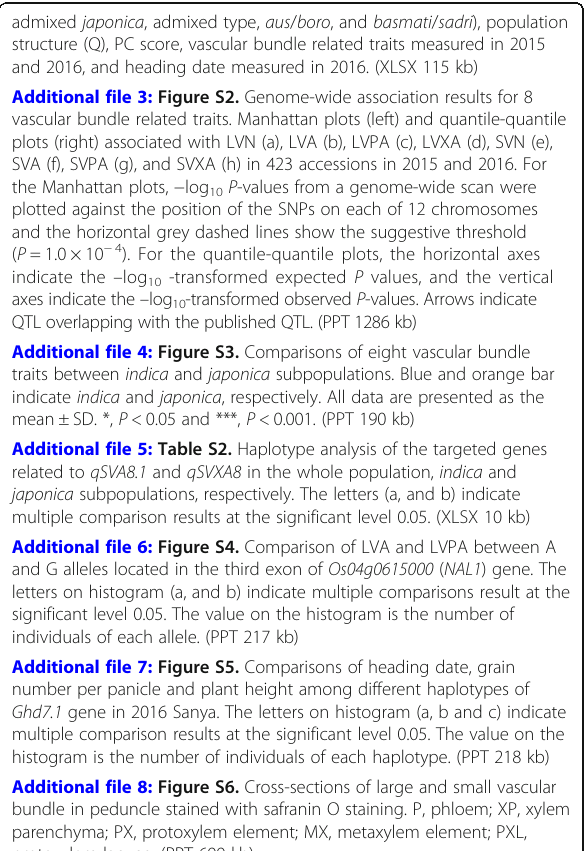
Additional file 3: Figure S2. Genome-wide association results for 8 vascular bundle related traits. Manhattan plots (left) and quantile-quantile plots (right) associated with LVN (a), LVA (b), LVPA (c), LVXA (d), SVN (e), SVA (f), SVPA (g), and SVXA (h) in 423 accessions in 2015 and 2016. For the Manhattan plots, − log 10 P -values from a genome-wide scan were plotted against the position of the SNPs on each of 12 chromosomes and the horizontal grey dashed lines show the suggestive threshold ( P = 1.0 × 10 − 4 ). For the quantile-quantile plots, the horizontal axes indicate the – log 10 -transformed expected P values, and the vertical axes indicate the – log 10 -transformed observed P -values. Arrows indicate QTL overlapping with the published QTL. (PPT 1286 kb) Additional file 4: Figure S3. Comparisons of eight vascular bundle traits between indica and japonica subpopulations. Blue and orange bar indicate indica and japonica , respectively. All data are presented as the mean ±SD. *, P < 0.05 and ***, P < 0.001. (PPT 190 kb) Additional file 5: Table S2. Haplotype analysis of the targeted genes related to qSVA8.1 and qSVXA8 in the whole population, indica and japonica subpopulations, respectively. The letters (a, and b) indicate multiple comparison results at the significant level 0.05. (XLSX 10 kb) Additional file 6: Figure S4. Comparison of LVA and LVPA between A and G alleles located in the third exon of Os04g0615000 ( NAL1 ) gene. The letters on histogram (a, and b) indicate multiple comparisons result at the significant level 0.05. The value on the histogram is the number of individuals of each allele. (PPT 217 kb) Additional file 7: Figure S5. Comparisons of heading date, grain number per panicle and plant height among different haplotypes of Ghd7.1 gene in 2016 Sanya. The letters on histogram (a, b and c) indicate multiple comparison results at the significant level 0.05. The value on the histogram is the number of individuals of each haplotype. (PPT 218 kb) Additional file 8: Figure S6. Cross-sections of large and small vascular bundle in peduncle stained with safranin O staining. P, phloem; XP, xylem parenchyma; PX, protoxylem element; MX, metaxylem element; PXL, protoxylem lacuna. (PPT 699